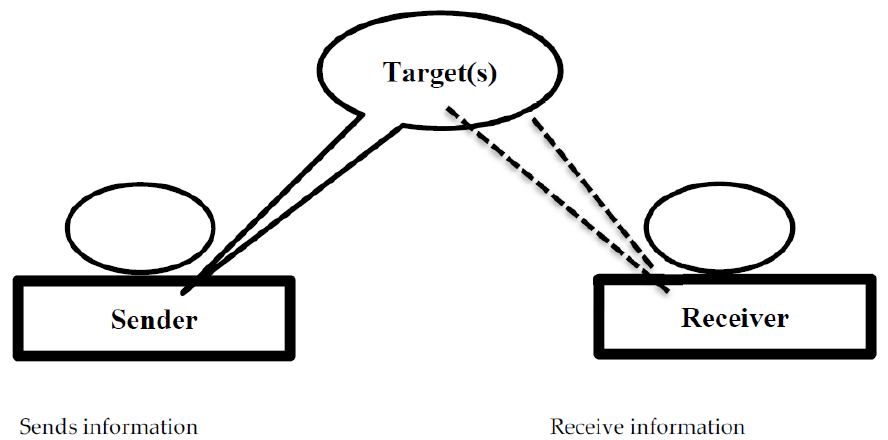
Figure 1. Gossip triad [2,34]. Note: The gossip triangle has three “actors”: sender, target, and receiver.